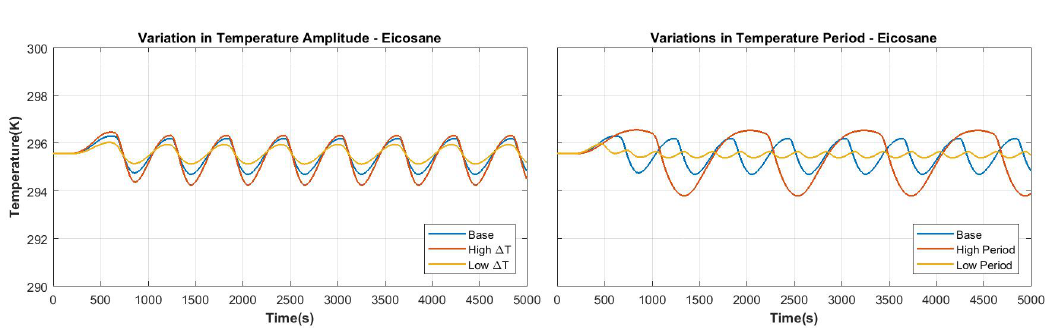
Figure 11. Results of eicosane at Re = 1000 with amplitudes of 10, 20, 30 K and periods of 5, 10, 20 min. Variations due to amplitude differences are seen to be clipped at the maximum at the same point even with higher temperature variations. Higher period oscillations allow for higher max temperature with more pronounced